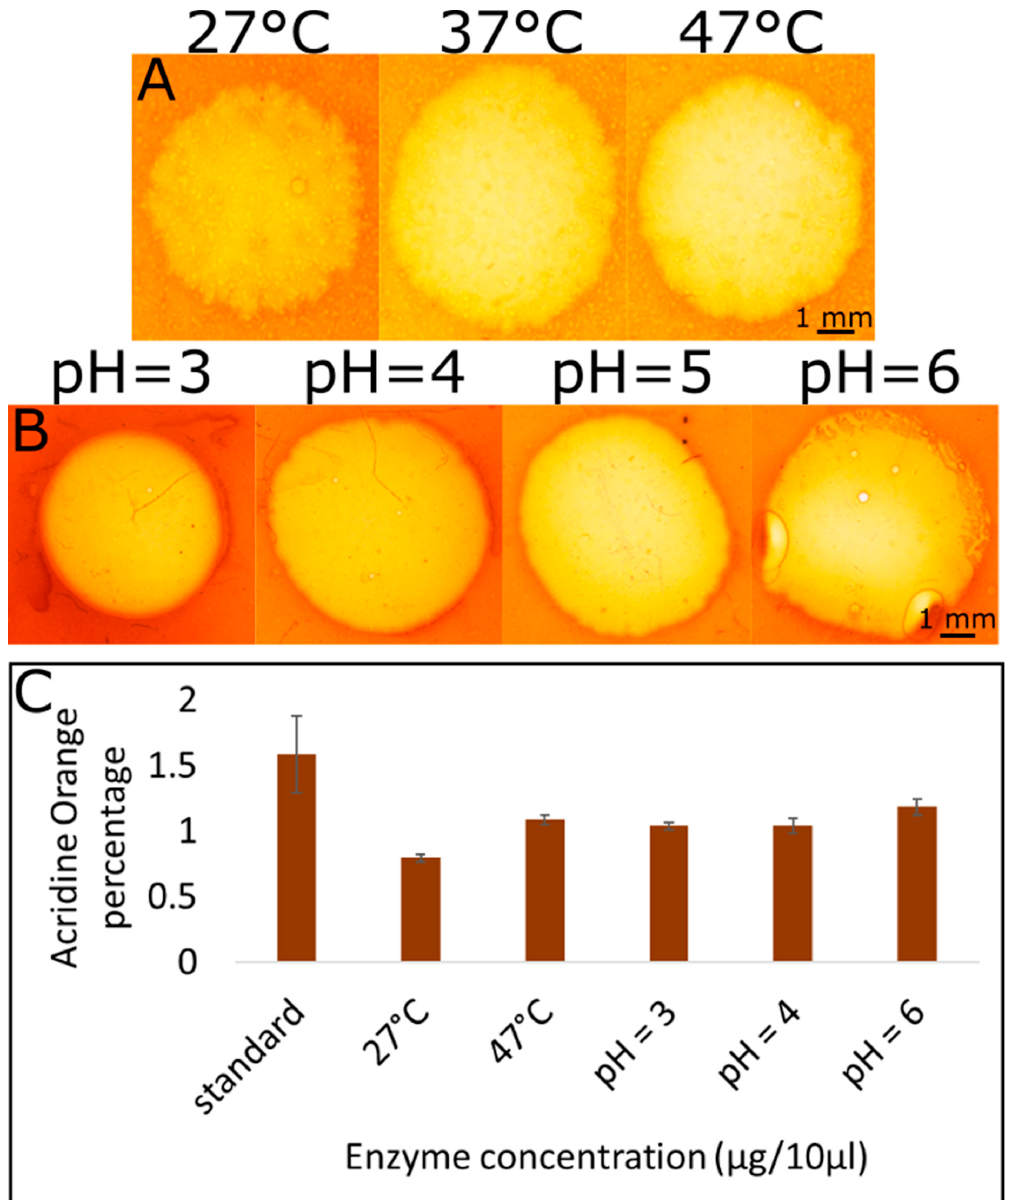
Figure 4. Effect of temperature and pH. ( A ) Dyed CMC films were subjected to 10 μ L containing 10 μ g of cellulase and incubated for 2 h at 3 different temperatures (27 °C, 37 °C and 47 °C). Then, the films were washed and visualized using a streomicroscope. The halo was biggest and brightest at 37 °C. ( B ) The dyed CMC films were washed with acetate buffer at different pH values (3, 4, 5, and 6) and then subjected to 10 μ g cellulase enzyme in 10 μ L of the same pH as the acetate buffer. Then, the films were incubated at 37 °C for 2 h followed by washing and visualization. ( C ) UV-vis spectroscopy measuring the percentage of acridine orange released out of the total acridine orange added to the plate at different temperature and pH conditions. Standard conditions denote pH = 5 and a temperature of 37 °C.